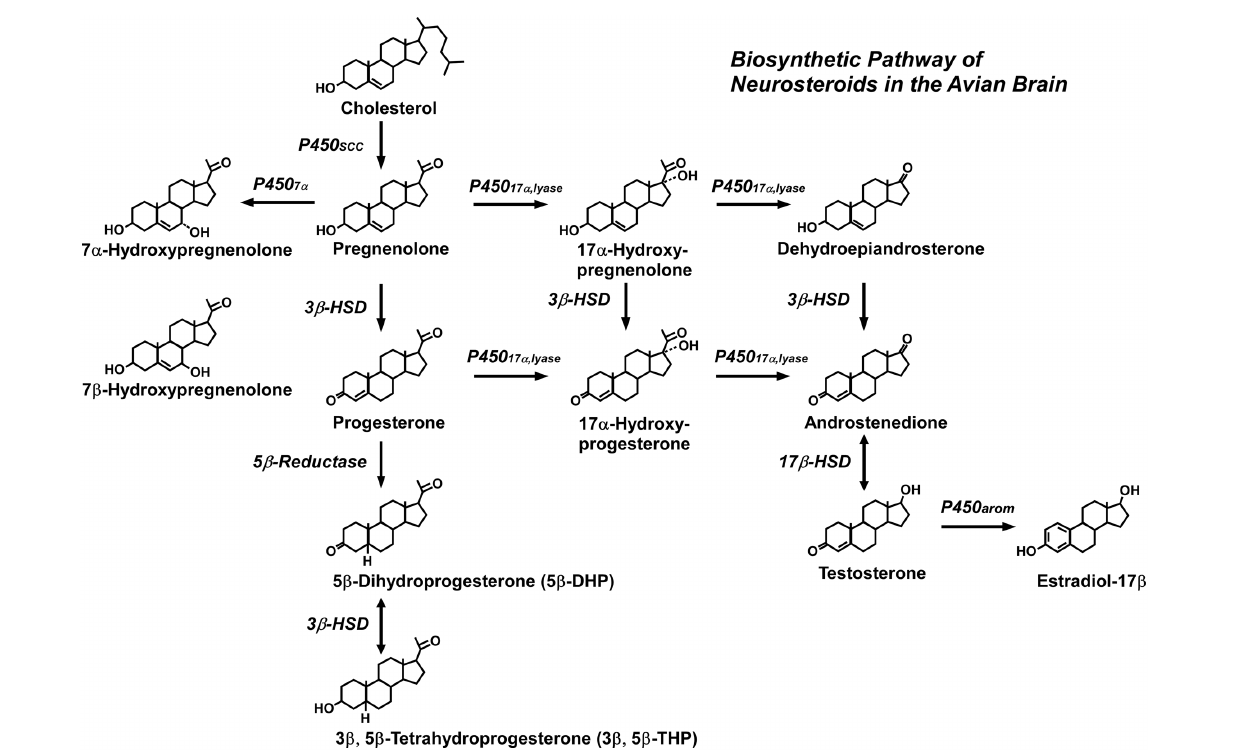
FIGURE 8 | Biosynthetic pathway for neurosteroids in the quail brain. The arrows indicate biosynthetic pathways of neurosteroids identified in the quail brain. See the text for